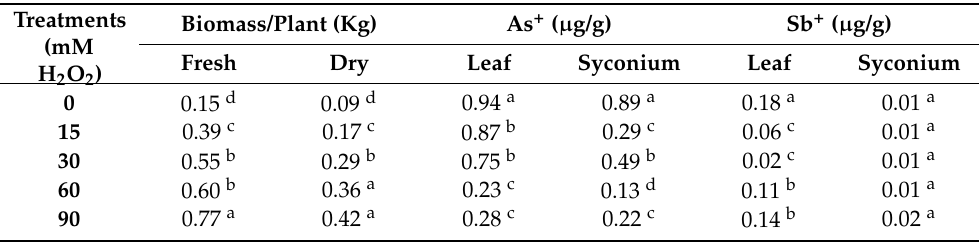
Table 4. Plant biomass, arsenic (As + ) and antimony (Sb + ) content in leaf and syconium of F. deltoidea plants affected by exogenous H 2 O